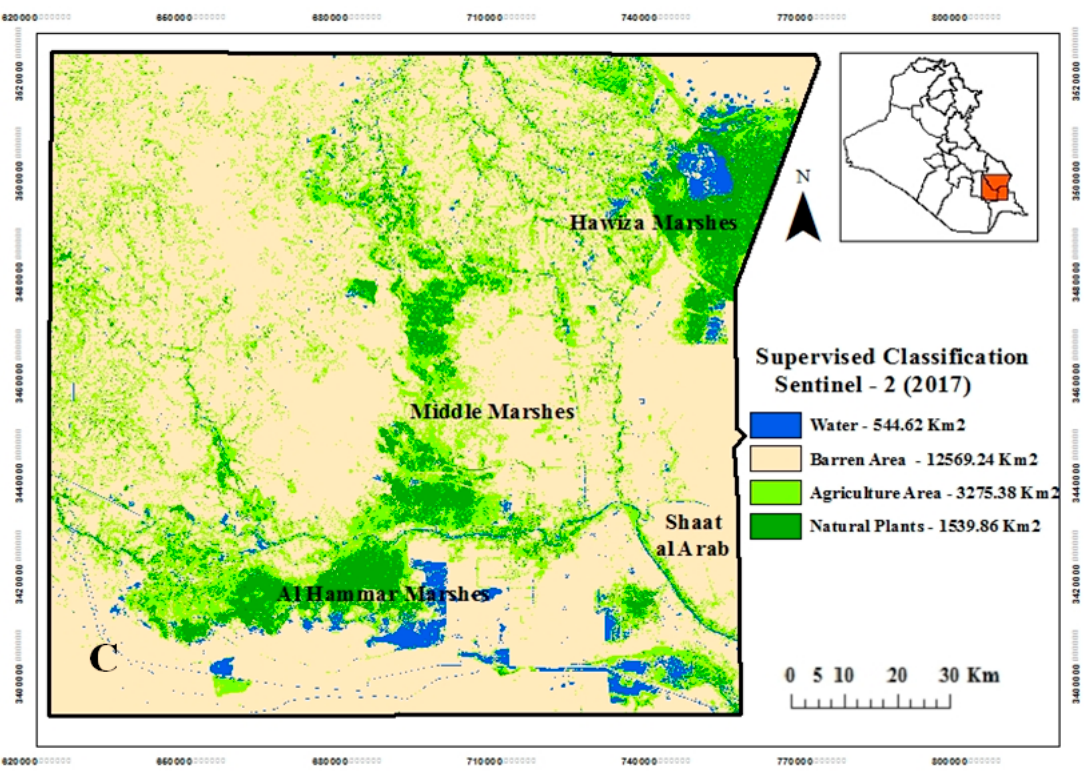
Figure 5. Supervised classification for Iraqi southern marshes: ( A ) Landsat 2 in 1977, ( B ) Landsat 8 in 2017 and ( C ) Sentinel 2 2017.